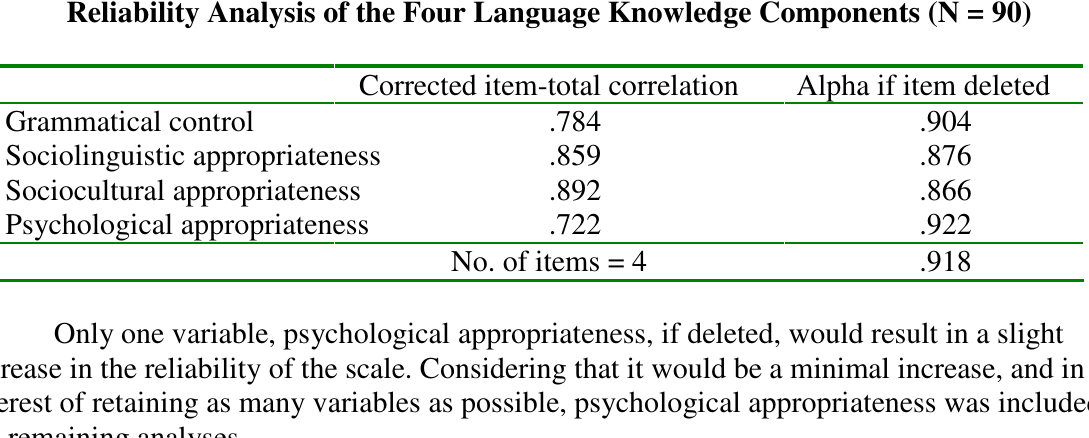
Reliability Analysis of the Four Language Knowledge Components (N =